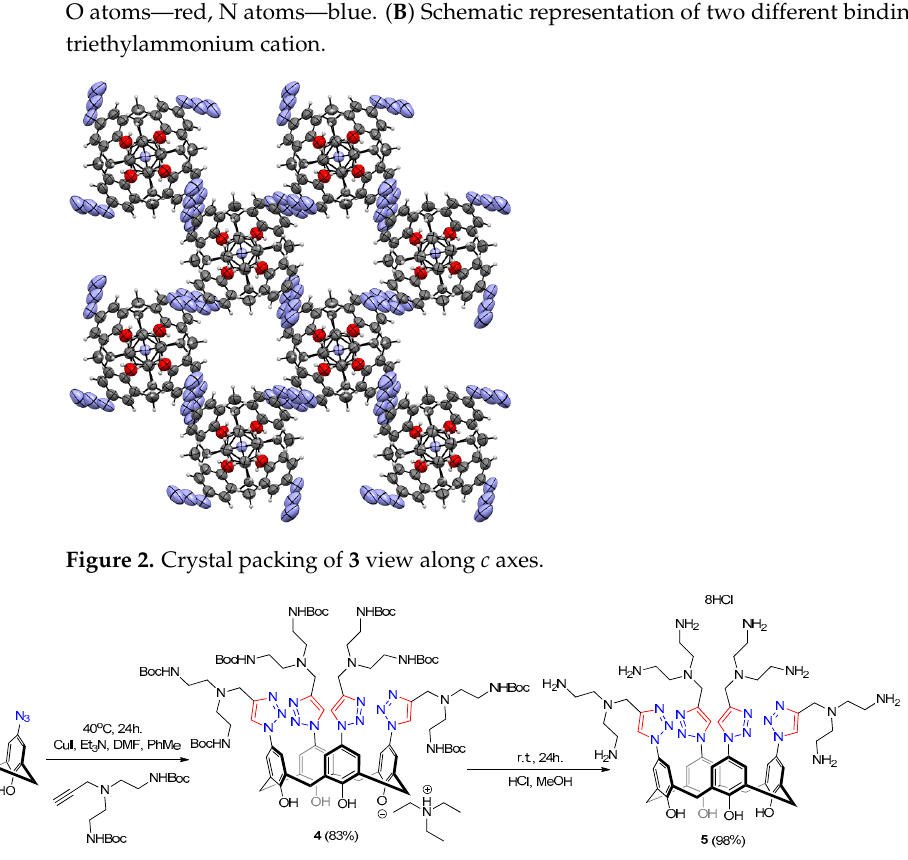
Figure 1. ( A ) ORTEP representation of 3 showing 20% probability thermal ellipsoids. C atoms— grey, O atoms—red, N atoms—blue. ( B ) Schematic representation of two different binding modes with triethylammonium cation.